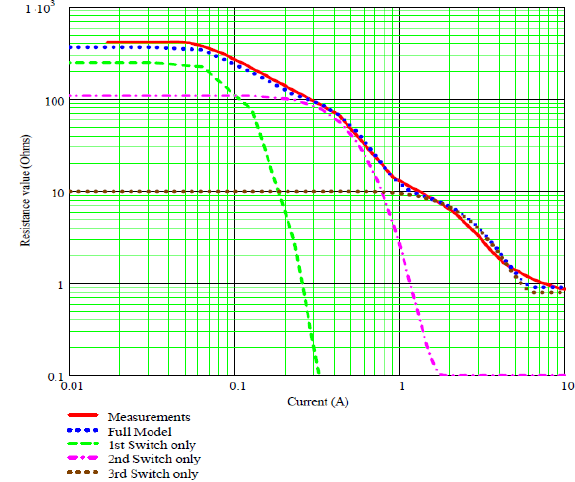
Figure 18: R(I) measured compared to model for model from Fig. 17.